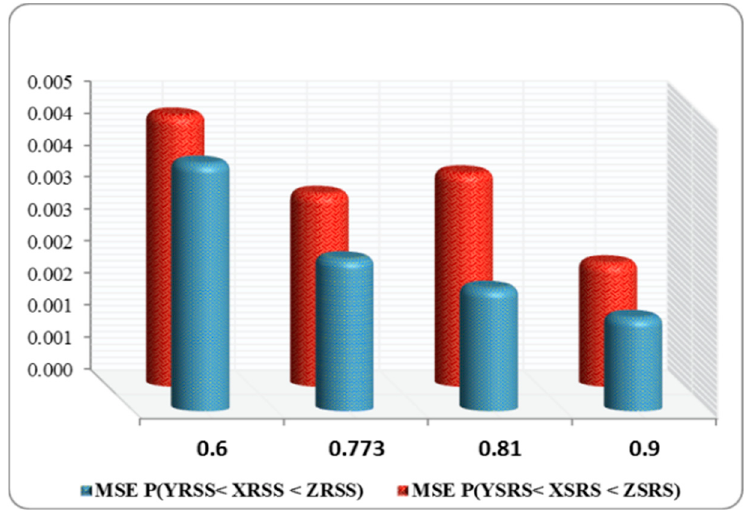
(cid:0) (cid:1) = ( ˆ  for (n (cid:2870)∗ , n (cid:2869)∗ , n (cid:2871)∗ (cid:4667) = (10,30,10(cid:4667) at di ff erent values of  . n ∗ , n ∗ , n ∗ 10,30,10 ) at different values of R . Figure 4. MSE of 2 3 1 2